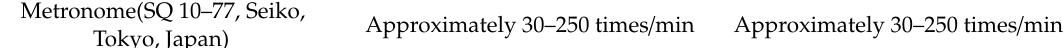
Figure 5. Vibration tests (walking loads): ( a ) Frame completion; ( b ) Cladding completion.